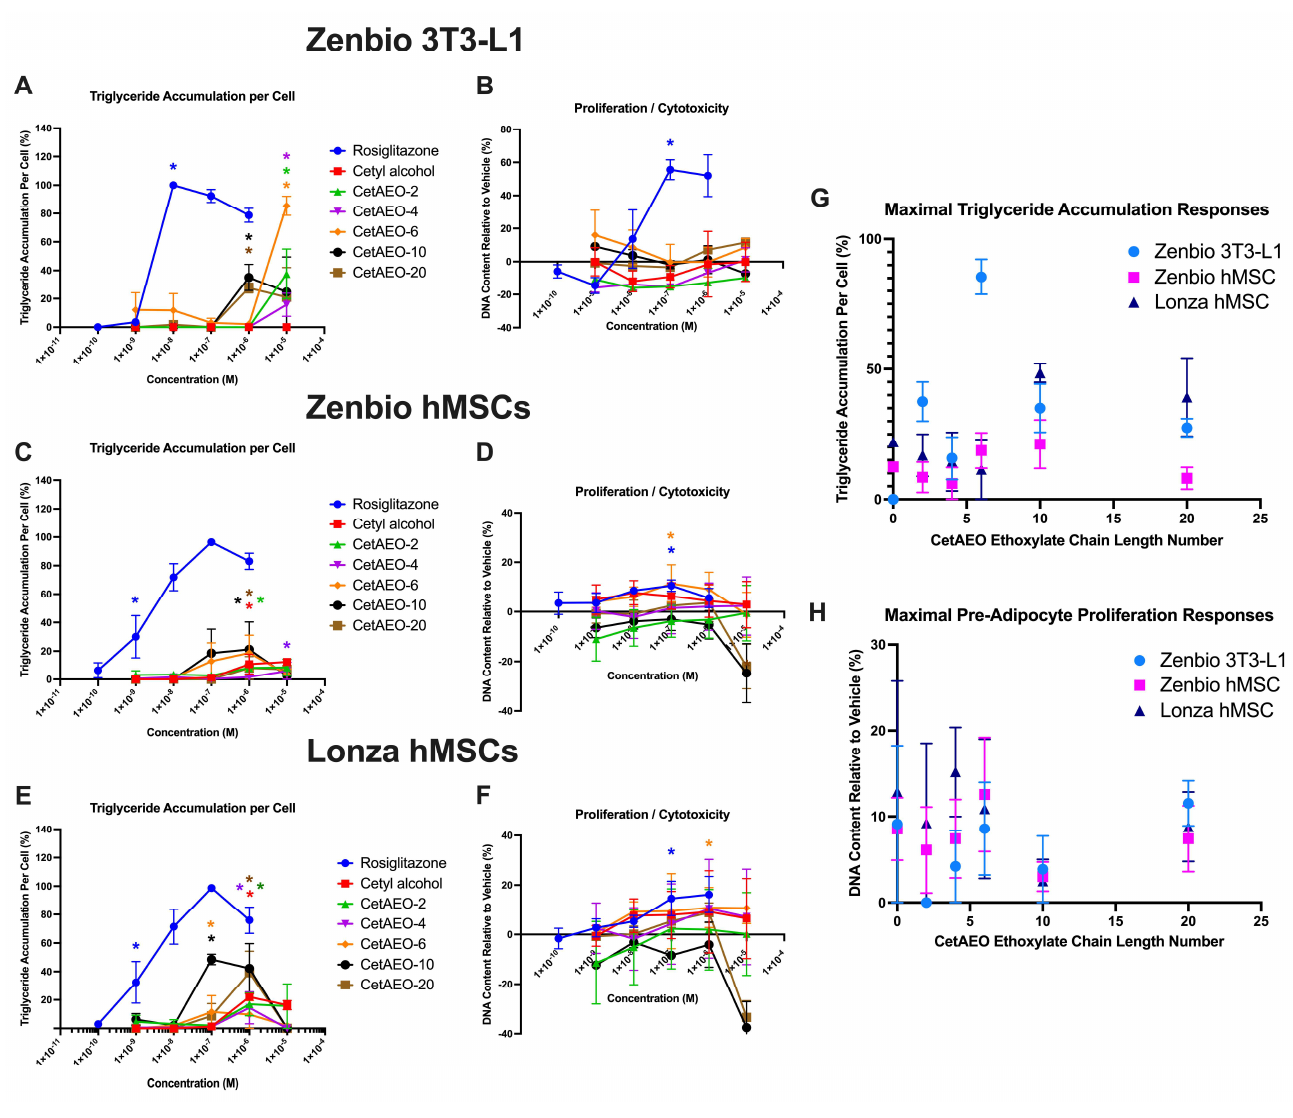
Figure 1. Cetyl alcohol and Polyethoxylates Promote Adipogenesis in Mouse Pre-adipocytes and Human Mesenchymal Stem Cell Models. Murine 3T3−L1 and both Zenbio and Lonza−sourced hu- man bone marrow−derived mesenchymal stem cell models were differentiated as described in Methods and assessed for adipocyte differentiation (Nile Red staining of lipid accumulation) and cell proliferation (NucBlue ® Live ReadyProbes ® Reagent staining) after 10/21/21 (respectively) days of differentiation while exposed to controls chemicals as well as cetyl alcohol and its